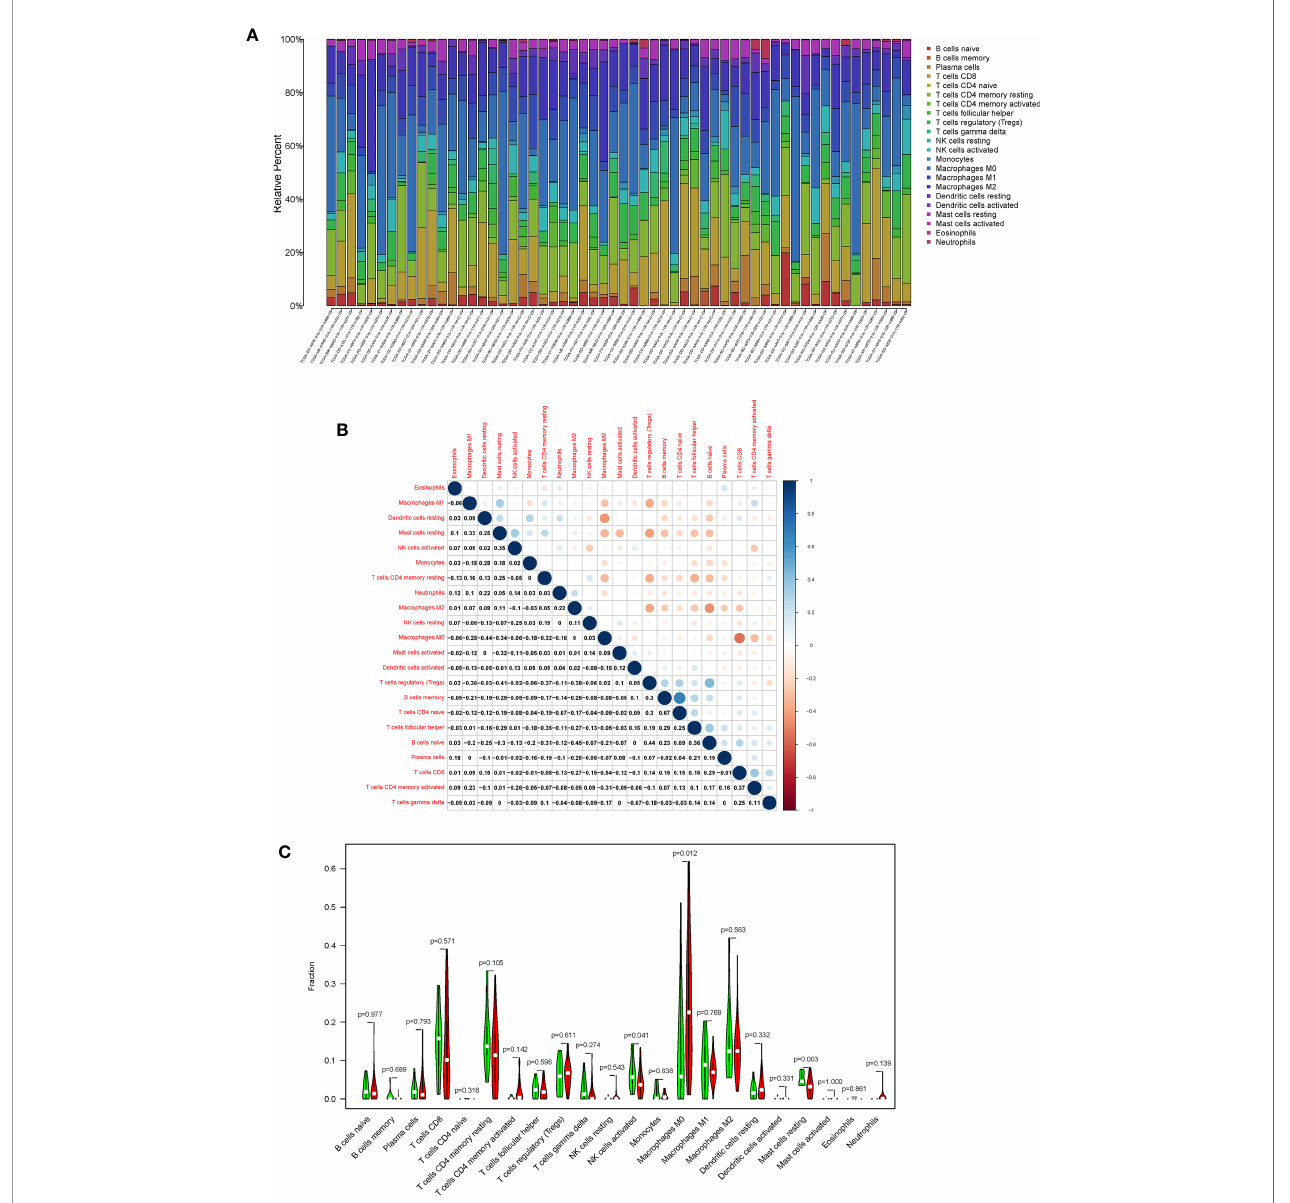
FIGURE 8 | TIC pro fi le in tumor samples and correlation analysis. (A) Barplot showing the proportion of 21 kinds of TICs in HCC tumor samples; (B) Heatmap showing the correlation between 21 kinds of TICs and numeric; (C) Violin plot showed the ratio differentiation of 21 kinds of immune cells between HCC samples with high CXCL5 expression and low CXCL5